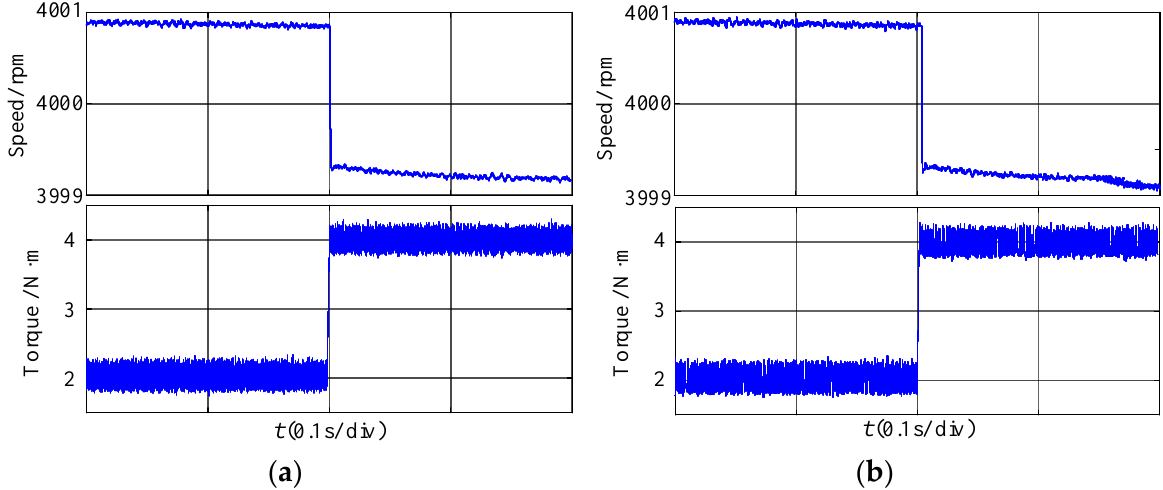
( a ) Without resonant controller; ( b ) with resonant controller.